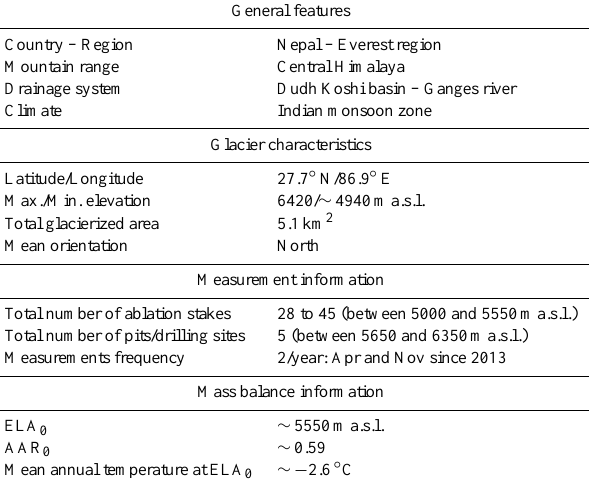
Table 1. List of geographical and topographical characteristics of Mera Glacier. ELA 0 and AAR 0 are the calculated equilibrium- line altitude and accumulation-area ratio values respectively for a zero glacier-wide balance given the 2012 hypsography. Mean an- nual temperature at ELA 0 is derived from the AWS located